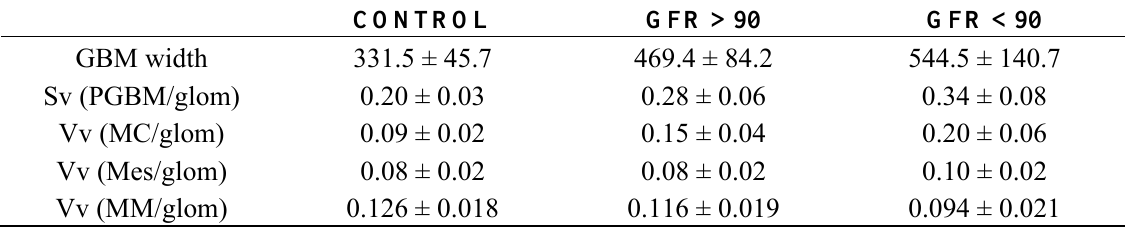
Table 1. Glomerular structural characteristics in normoalbuminuric Type 1 diabetic patients compared with nondiabetic control subjects (modified from Caramori et al.